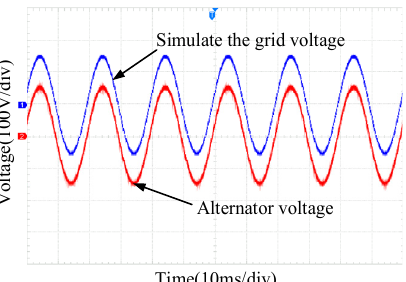
Figure 15. Output voltage waveforms for the grid and DFIG before grid connection.